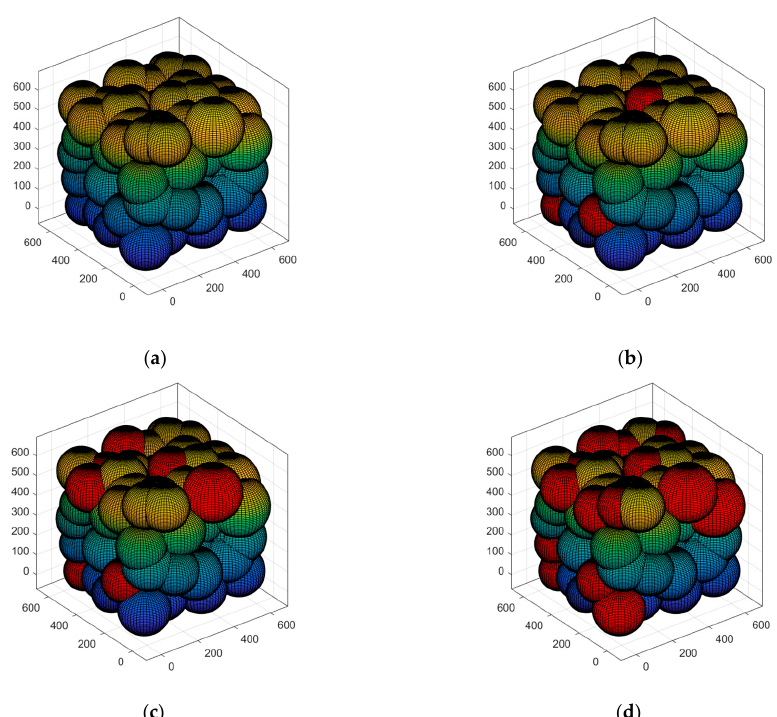
Figure 13. Different rounds of coverage in large networks: ( a ) Network runs 50 rounds; ( b ) Network runs 5000 rounds; ( c ) Network runs 10,000 rounds; ( d ) Network runs 15,000 rounds.